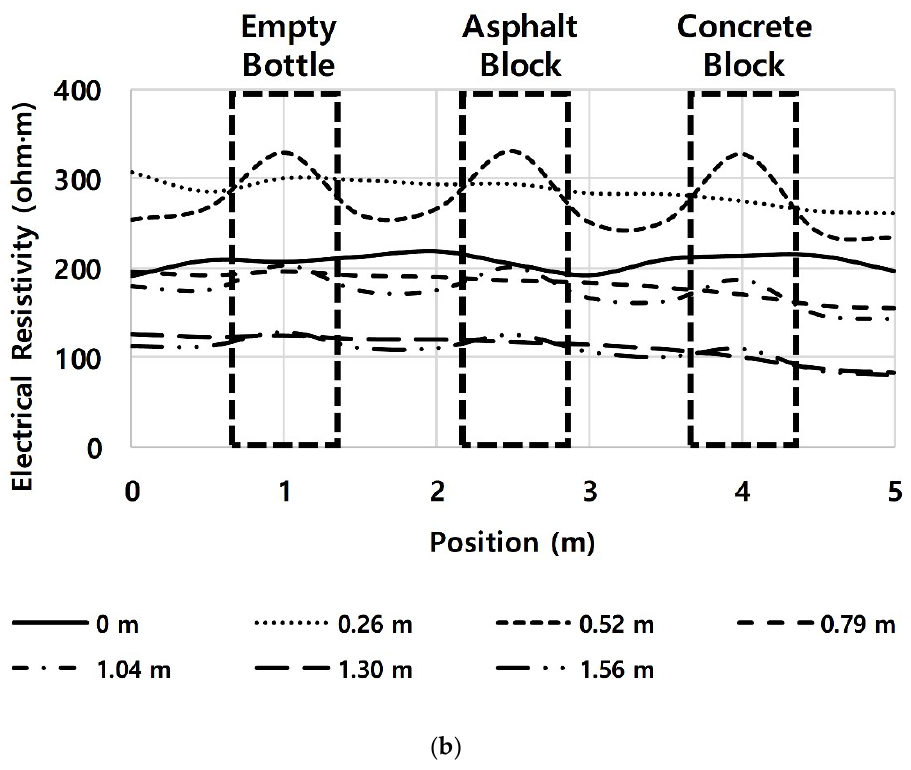
Figure 10. Test result for the underground facilities (Section No. 6). ( a ) Distribution of the ER. ( b ) ER according to the position at each depth.